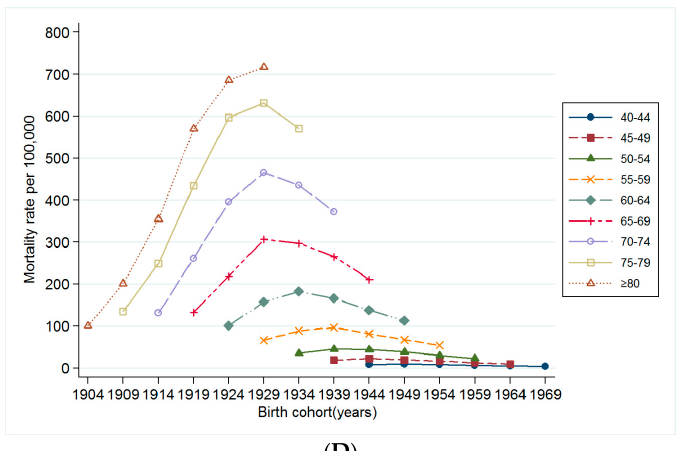
Figure 3. ( A ) Change in birth cohort specific mortality rate for oropharyngeal cancer by age group; ( B ) Change in birth cohort specific mortality rate for esophageal cancer by age group; ( C ) Change in birth cohort specific mortality rate for laryngeal cancer by age group; ( D ) Change in birth cohort specific mortality rate for lung cancer by age group.